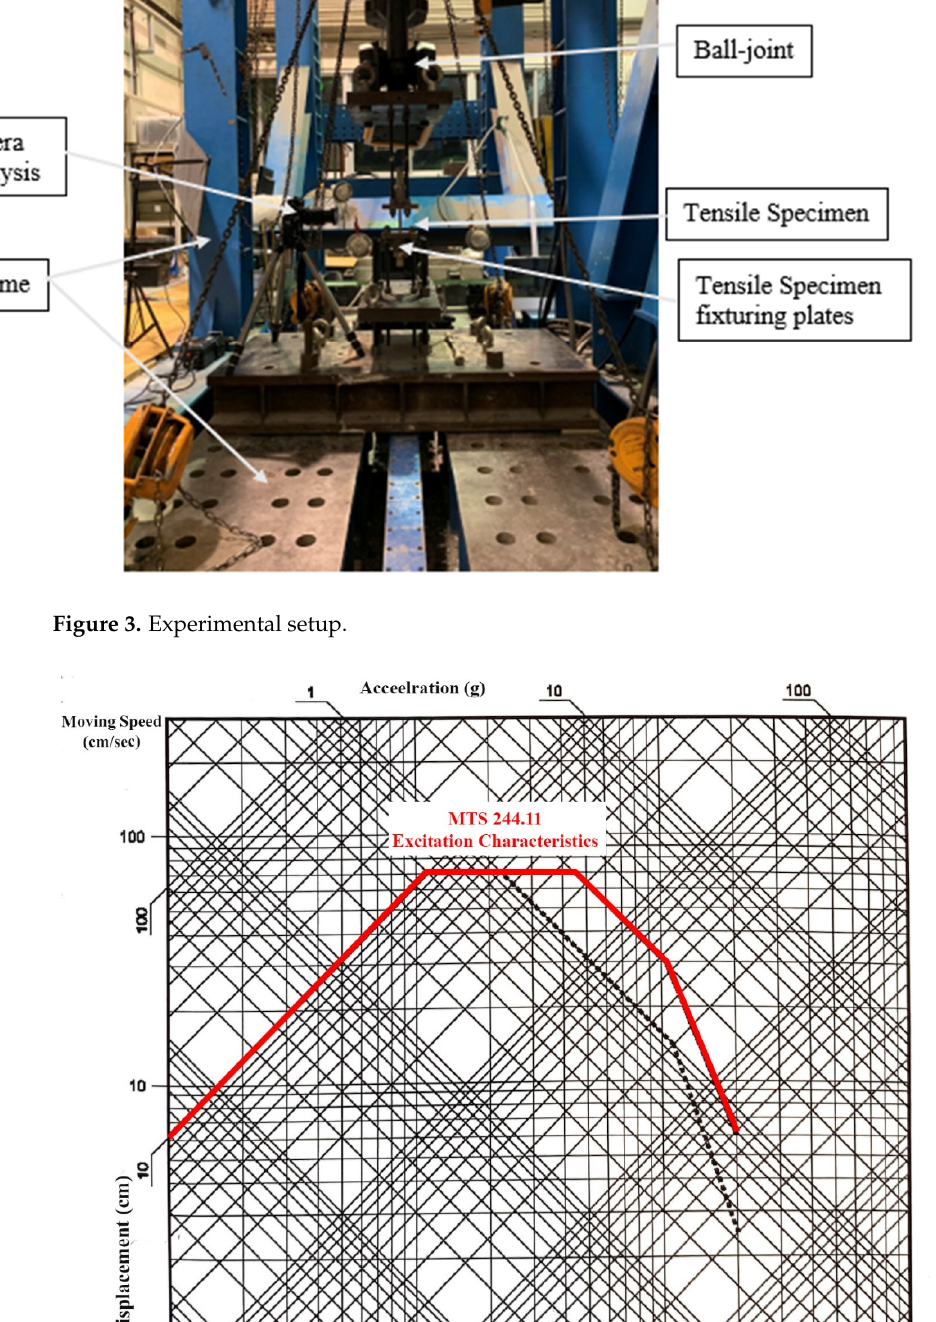
Figure 5. Detailed specimen fixture mechanism. From the flow stress–strain data of smooth (no notch) specimens (Figure 6a), it can be seen that for the same strain rate, similar stress–strain curves were obtained. For quasi- static strain rate (0.001 s − 1 ), this specific material showed the most ductile behavior